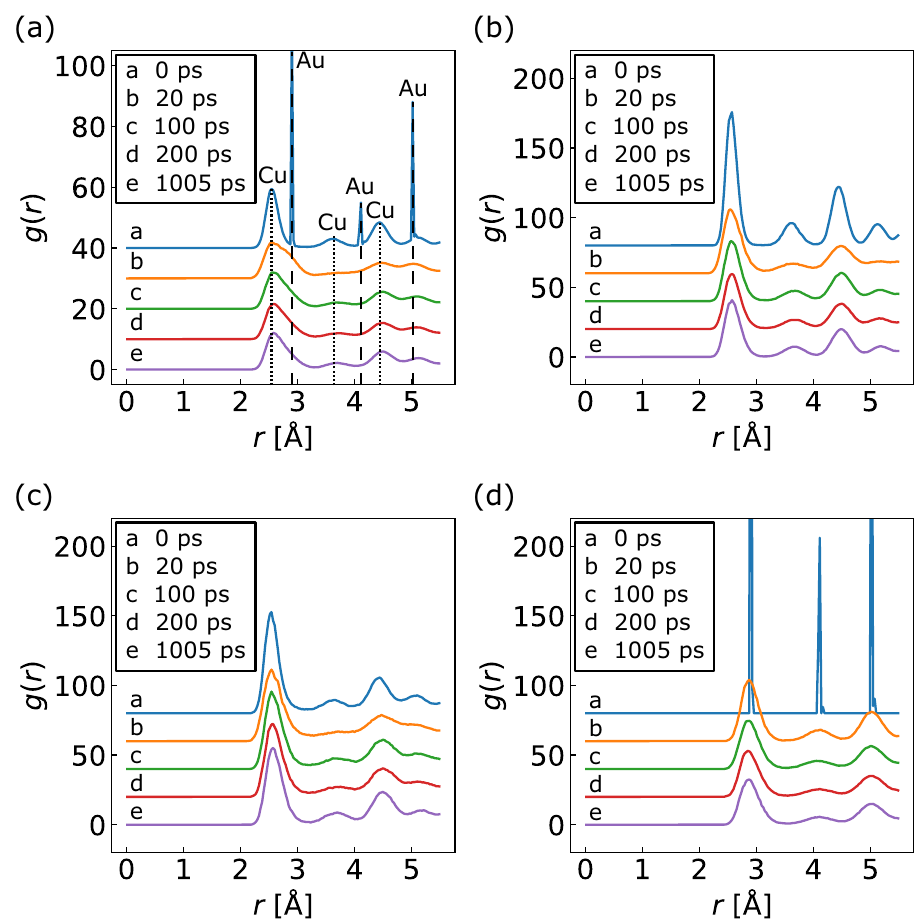
Figure 7. RDFs in the vicinity of NS-Cu at S v = 2.8 nm −1 at time steps of 0, 20, 100, 200, and 1005 ps; ( a ) Cu and Au atoms in total, ( b ) only the Cu slab, ( c ) only NS-Cu, and ( d ) only the Au slab. Numbers of atoms of the Cu slab, NS-Cu, and Au slab used in the RDF calculation are the same as those in the MSD calculation, as shown in Fig.